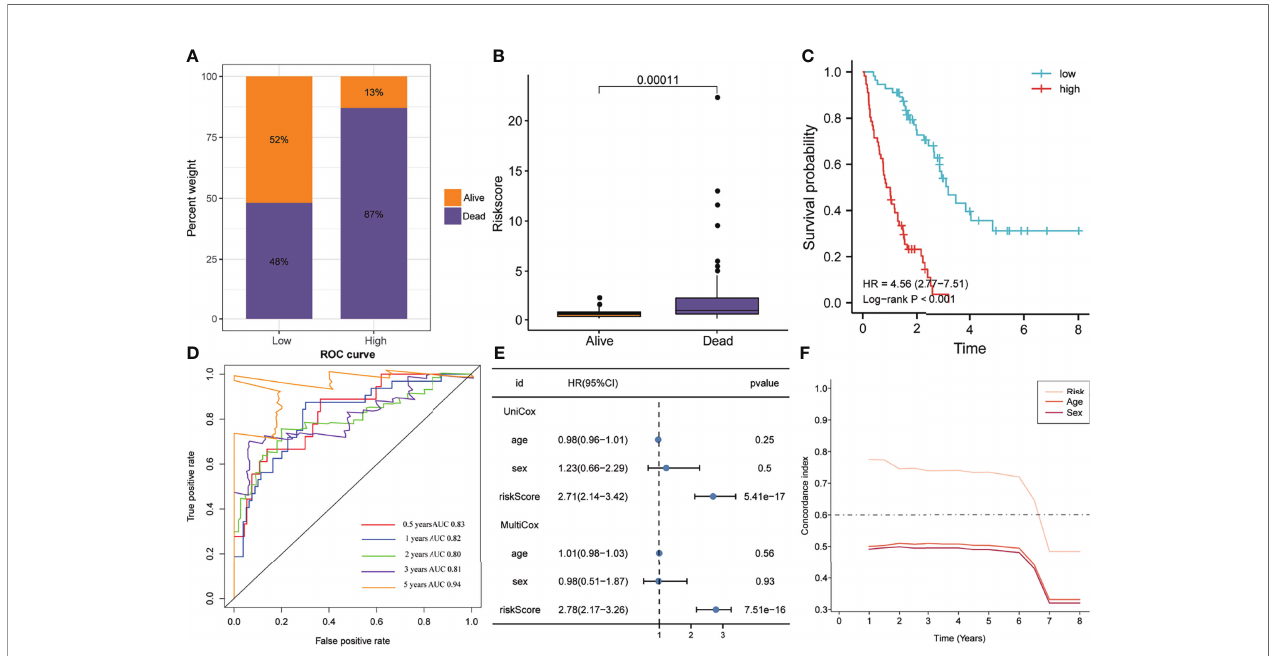
FIGURE 3 | The predictive ability of the signature in the training cohort. (A) Distribution of survival status in the high- and low-risk groups of the training cohort. (B) The distribution of the gene signature risk scores between the patients who have died and patients who are alive. (C) Kaplan-Meier method was performed to plot the survival curves based on risk scores, which were compared using log-rank test. (D) The area under the receiver operating characteristic curve value of the risk model for 0.5-, 1-, 2-, 3- and 5-years is 0.83, 0.82, 0.80, 0.81 and 0.94 respectively. (E) Univariate and multivariate Cox regression analyses suggested that this risk model was an independent prognostic factor. (F) Time-dependent concordance index exhibits the excellent predictive ability of the